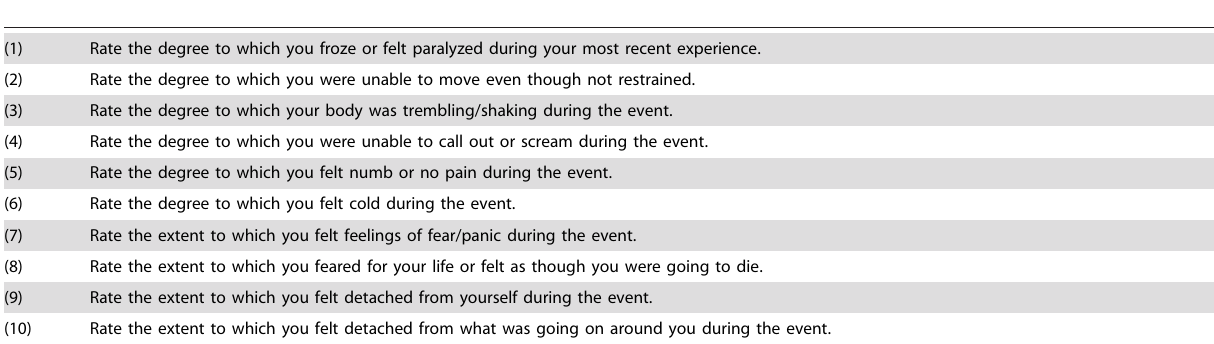
Table 1. Tonic Immobility Scale items used to compute the total